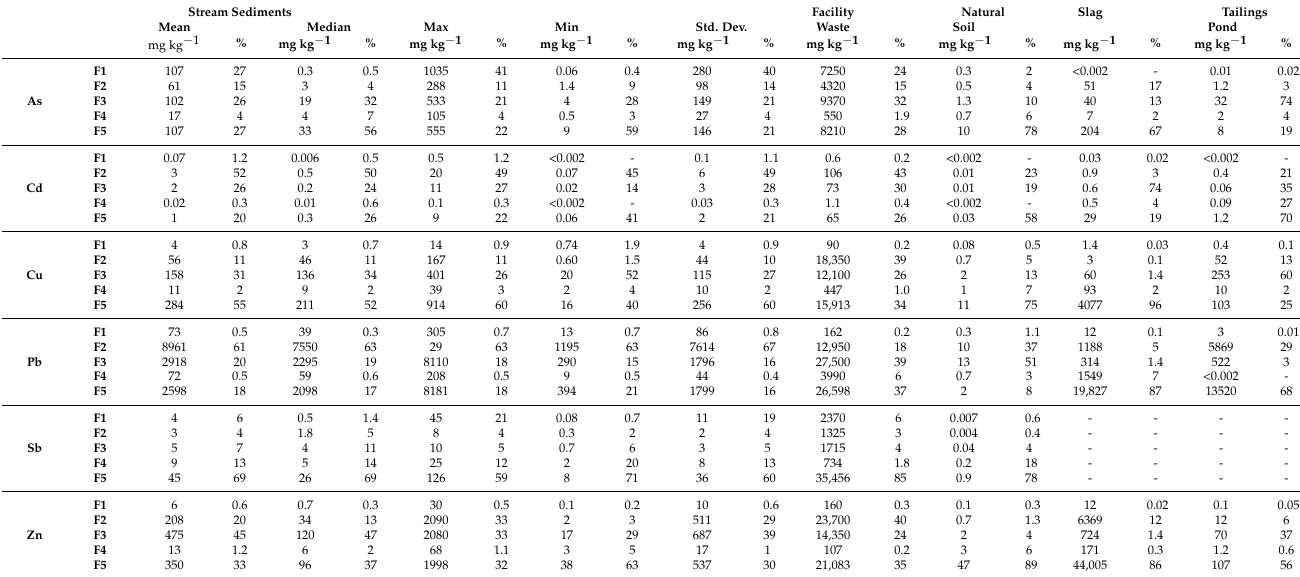
Table 2. The As, Cd, Cu, Pb, Sb and Zn contents of the F1–F5 fractions of the Baños Creek sediments, facility waste (SM-WAS), natural soil, slag from the La Cruz smelter and a tailings pond near the creek. Max: maximum, Min: minimum, Std. Dev.: standard